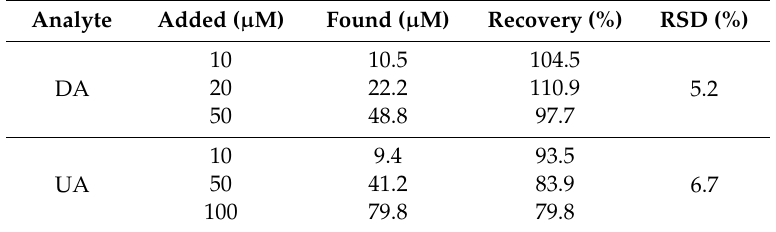
Table 4. Detection results of DA and UA in real sample using GCE / PFSG